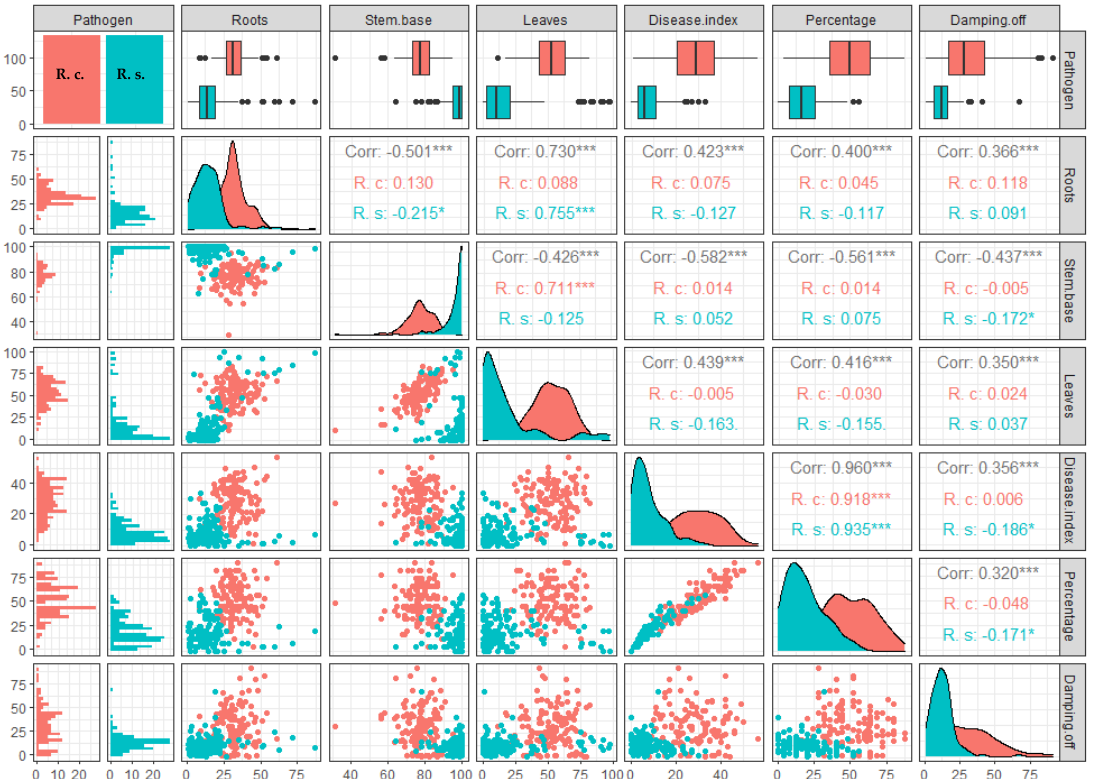
Figure 1. Correlation matrix between the studied variables depending on the species of pathogen used (R. c.—red color—R. cerealis; R. s.—blue color—R. solani; x, y axes—percentage of disease severity caused by Rhizoctonia species, Roots—roots disease index (%), Stem base—stem base disease index (%), Leaves—leaves disease index (%), Disease index—the disease index of plants in field trials (%), Percentage—the percentage of infected population showing symptoms (%), Damping-off (%)). *—significance level 0.05, ***—significance level